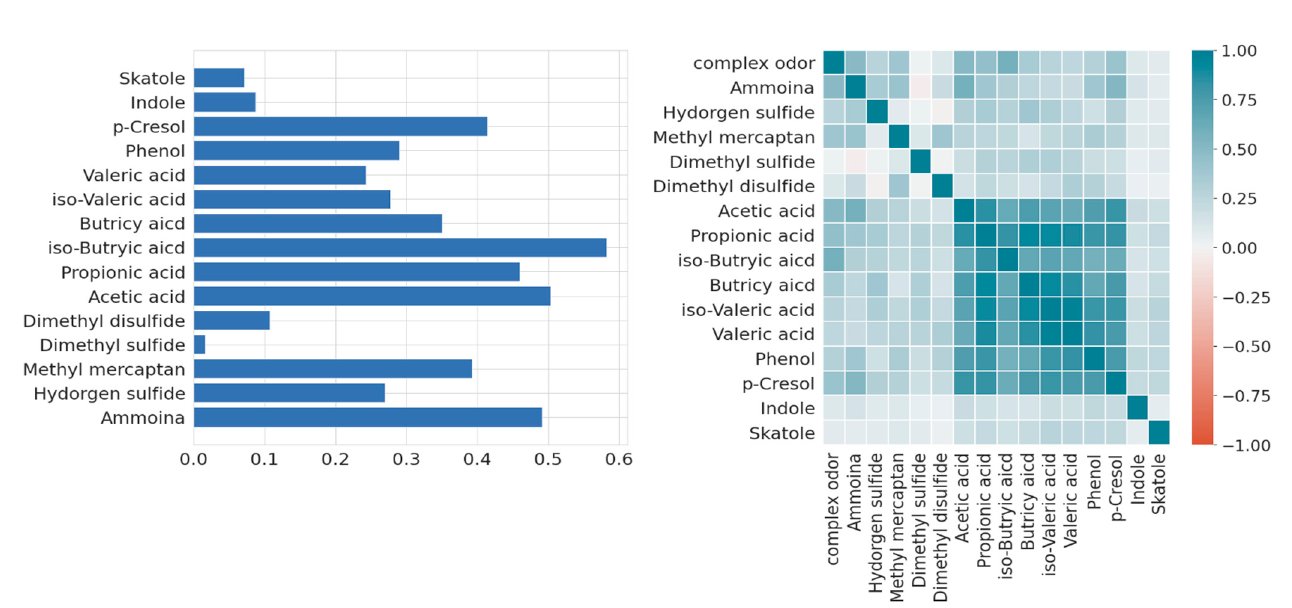
Figure 4. Correlation plot; ( left ) correlation bar plot of explanatory variables about response variables; ( right ) heatmap of data.